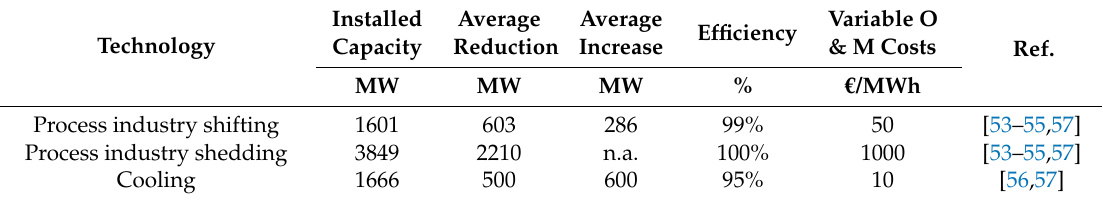
Table A9. Techno-economic parameters of demand response technologies.